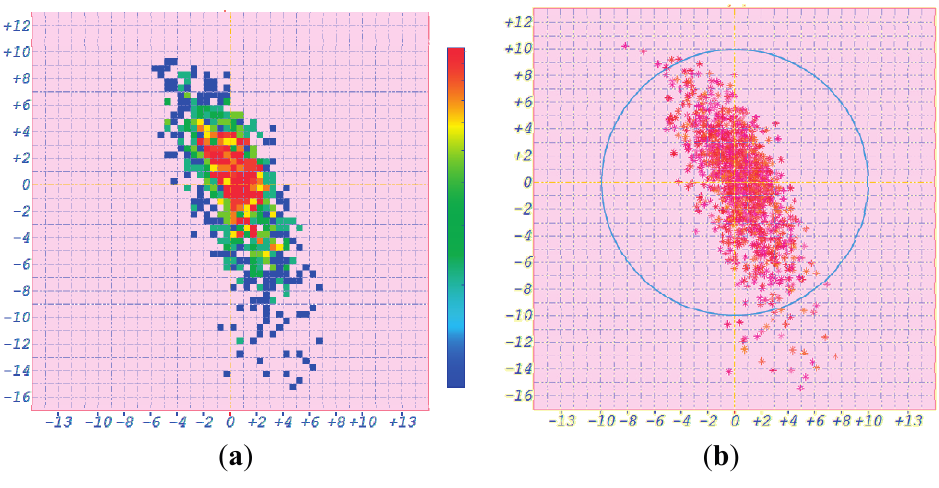
Figure 16. Positioning errors for the static position ( a ) Thermography diagram; ( b ) Scatter diagram